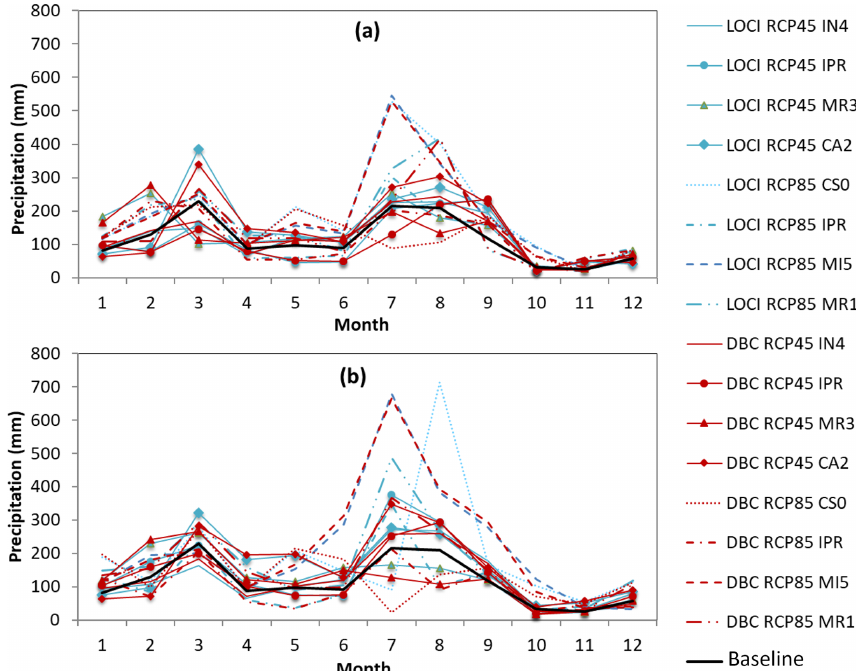
Figure 8. Monthly averages of observed precipitation (1986–2005) and projected future precipitations over the upper Beas basin during (a) 2046–2065 and (b) 2080–2099. Projections are shown for two bias-correction methods (LOCI and DBC) with two ensembles of four GCMs under RCP4.5 and RCP8.5 (Table